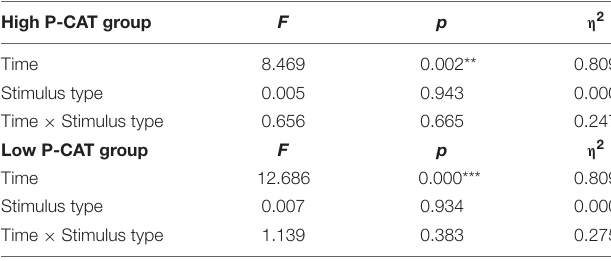
TABLE 3 | Summary of repeated measure ANOVA for two